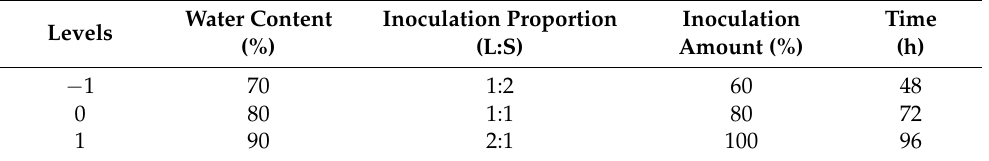
Table 1. Factors and levels in the response surface